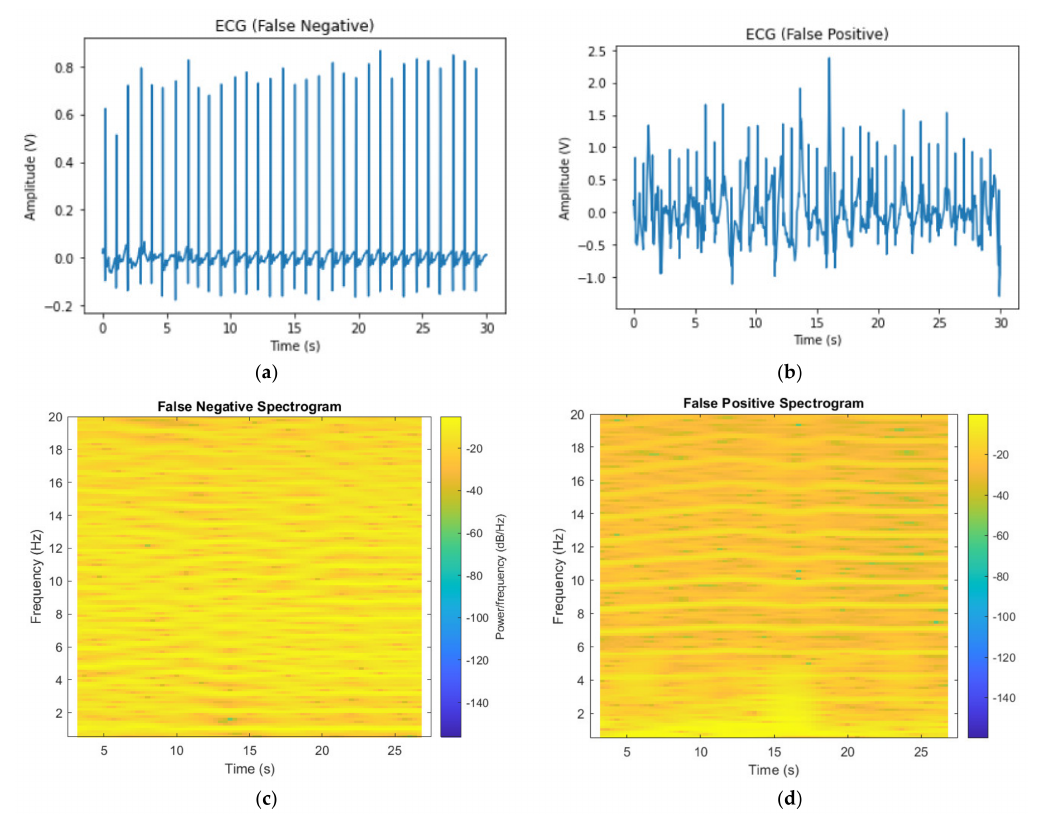
Figure 11. Examples of incorrect predictions: ( a ) False-negative ECG signal; ( b ) false-positive ECG signal; ( c ) false-negative spectrogram; ( d ) false-positive